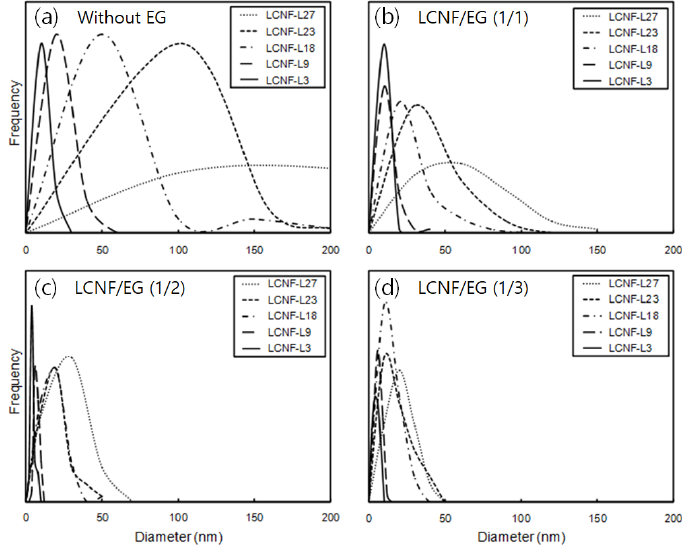
Figure 4. Diameter distribution of LCNFs with different lignin contents after enzymatic treatment using different EG contents; ( a ) without EG, ( b ) LCNF/EG (1/1), ( c ) LCNF/EG (1/2), ( d ) LCNF/EG (1/3). Table 3. Average diameter and standard deviations of LCNFs with different lignin contents after enzymatic treatment using different EG contents (units: nm).